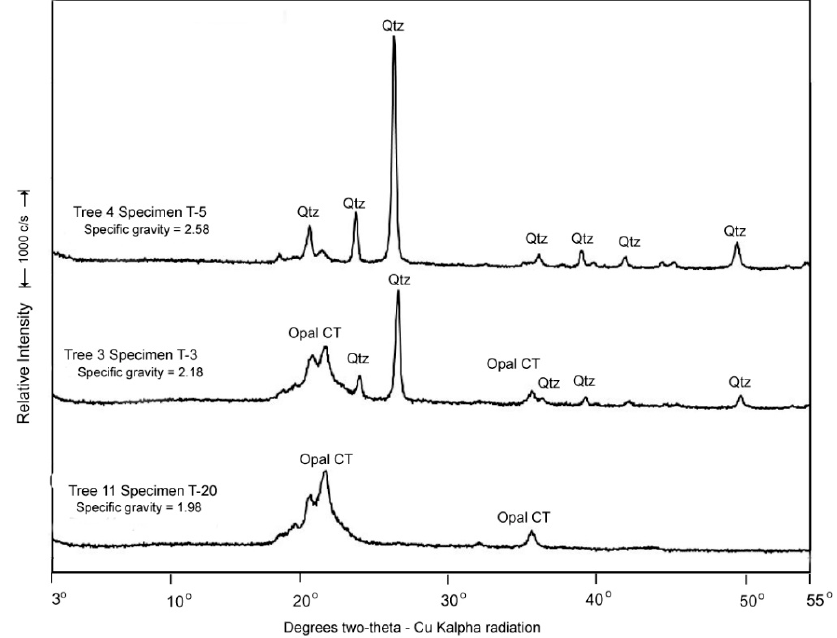
Figure 10. X-ray diffraction patterns for three typical specimens: T-3 (trunk 3), T-5 (trunk 4), T-20 (trunk 11). Optical microscope images of specimens T-3 and T-20 show amorphous opal-A as the predominant constituent, but X-ray patterns only show peaks for minor crystalline component opal-CT and quartz.